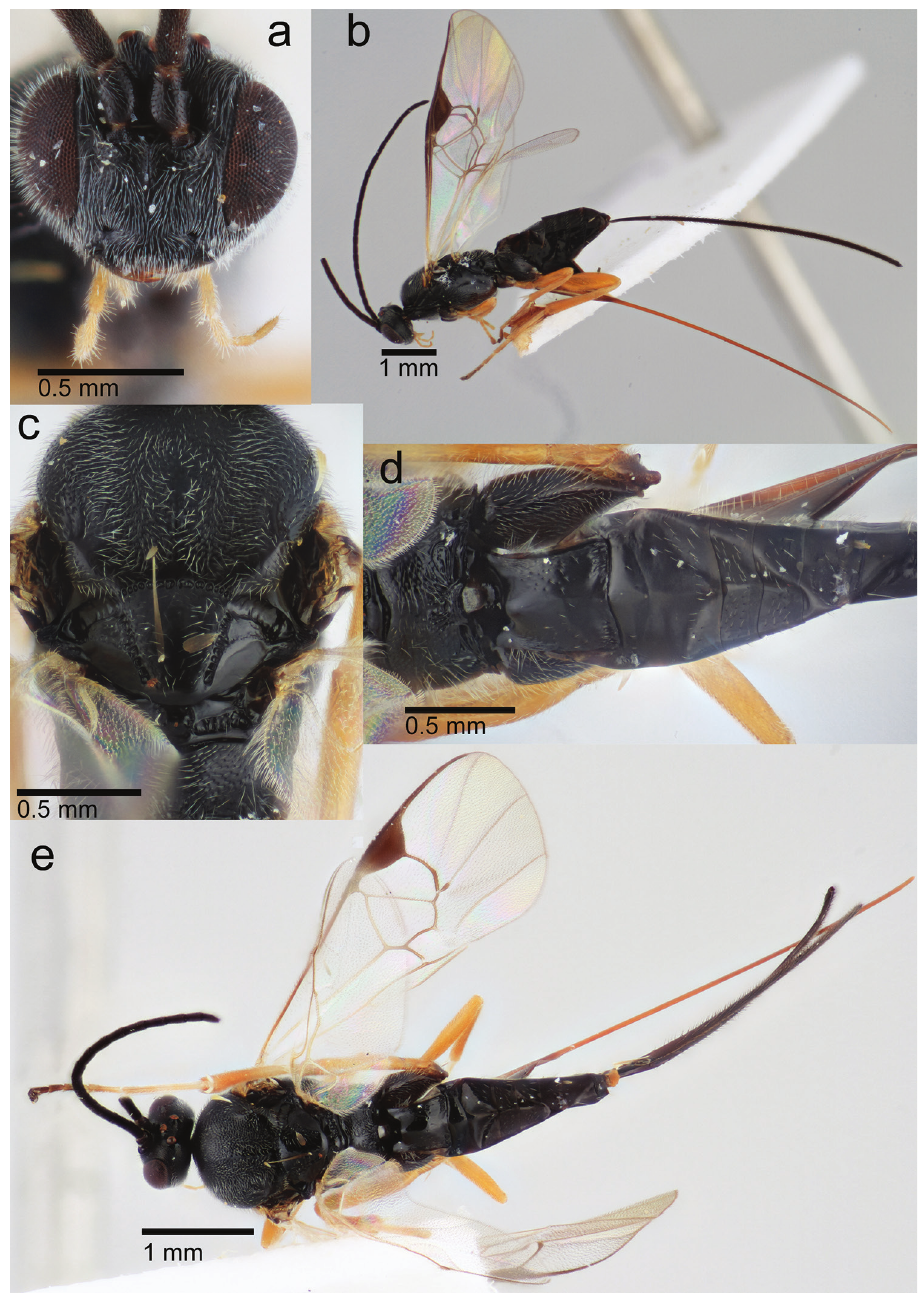
Figure 4. Dolichogenidea xenomorph : a head (paratype) b lateral habitus (paratype) c anteromesoscu- tum, mesoscutellum and metanotum (holotype) d propodeum and tergites (holotype) e dorsal habitus